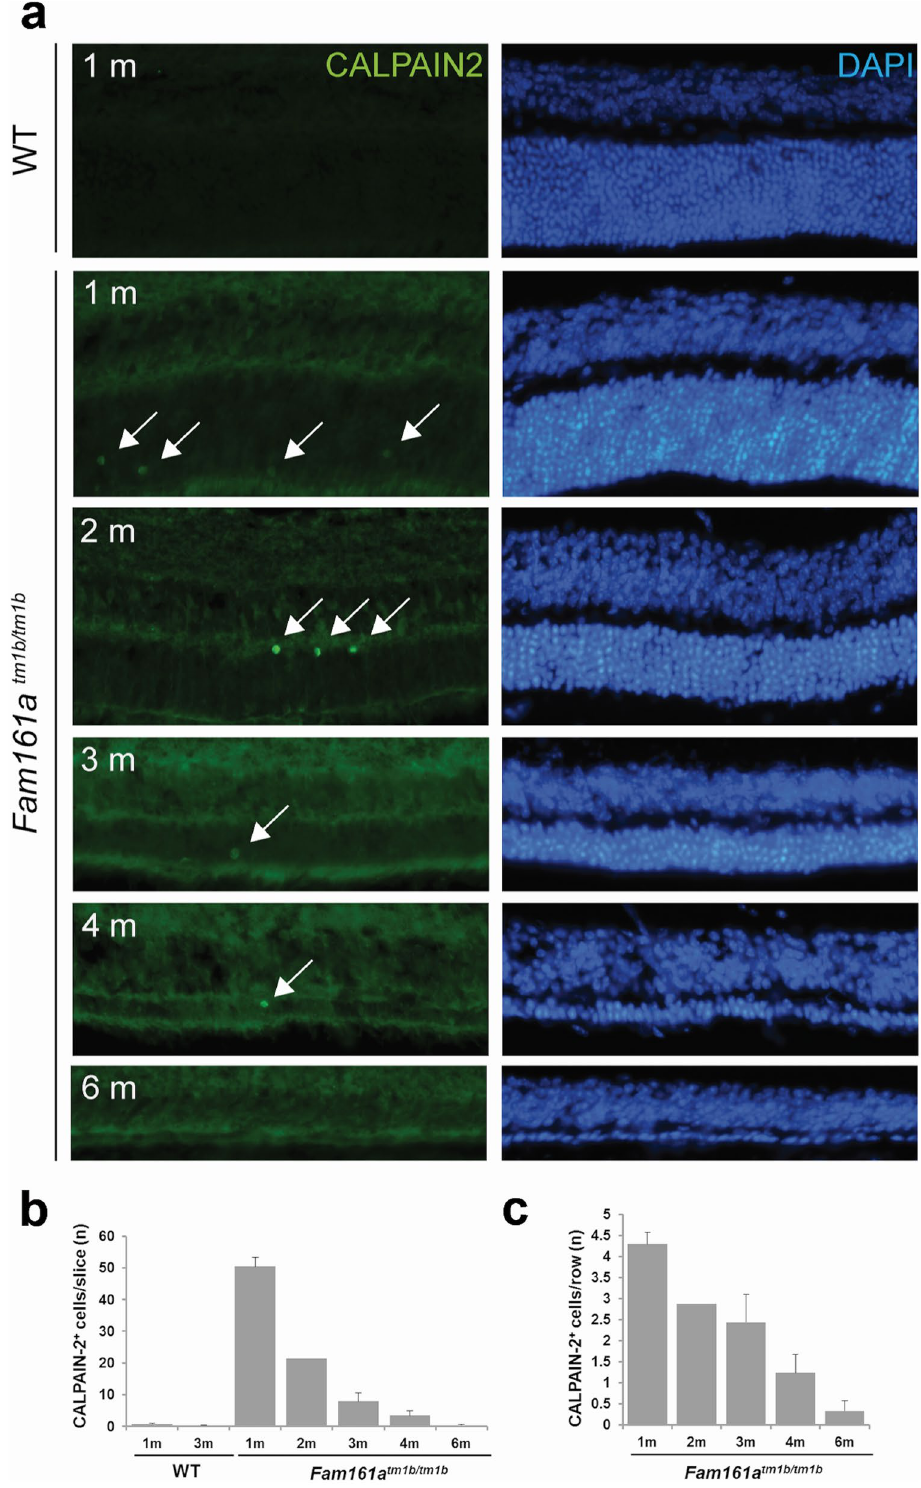
Figure 7. CALPAIN-2 is more present during the early stages of retinal degeneration. ( a ) CALPAIN-2 (in green, arrows) is present in the ONL of Fam161a tm1b/tm1b mouse all along the degenerative process, but the enzyme is almost absent in the WT retina (bottom). ( b ) The quantification of the absolute number of CALPAIN-2-positive cells shows that cell death is more prominent at 1 month. ( c ) The rate of the degeneration, evidenced by the number of CALPAIN-2-positive cells per row of photoreceptor, linearly declined with time. 1 m: 1 month. n = 3 for all time points, with the exception of 2 month old mice (n =